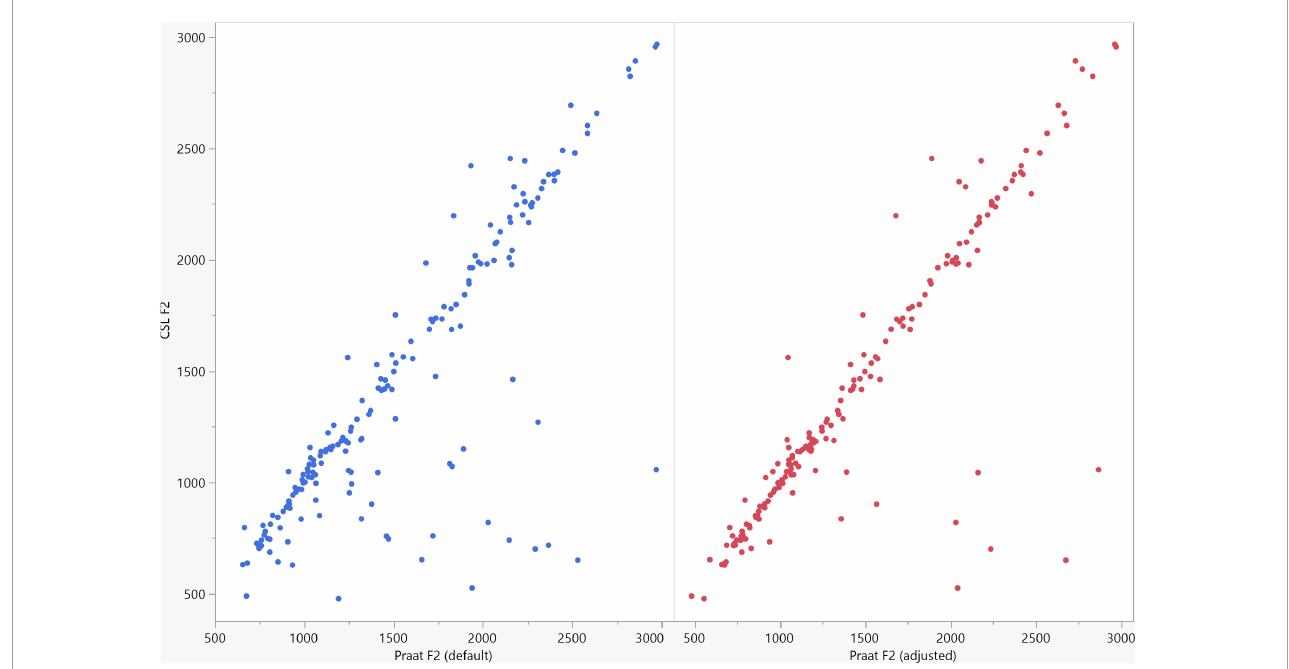
FIGURE8 Correlation between the F2 data of the five vowels calculated using Computerized Speech Lab (CSL) and Praat. The CSL F2 data showed strong positive correlations with those calculated by Praat for both the default (rs = 0.785, n = 185, p < 0.0001*) and adjusted (rs = 0.873, n = 185, p < 0.0001*) settings.